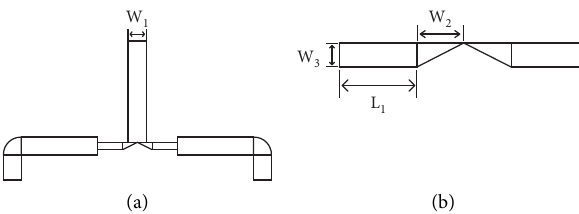
Figure 1: (a) Microstrip T-junction power divider with notch; (b) structure dimension of λ /4 microstrip impedance transformer.